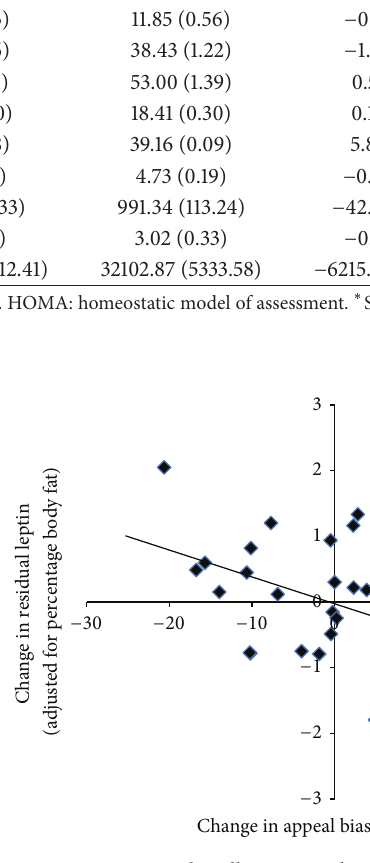
Figure 1: Scatter plot illustrating the relationship between the change in fasting leptin (adjusted for percentage body fat) following the exercise intervention and the change in appeal bias scores for liking for high fat foods ( 𝑛 = 32 ). Positive appeal bias = preference for high fat foods > low fat foods. Negative appeal bias score = preference for low fat foods > high fat